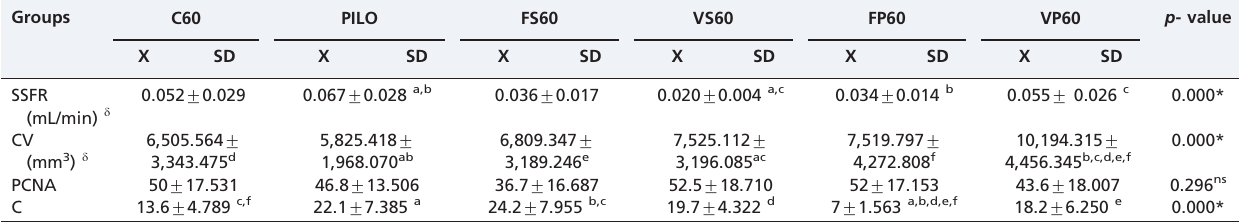
Table 3 - Mean values (X) and standard deviations (SD) of the studied variables in the groups treated for 60 days with saline (C60), pilocarpine (Pilo), fluoxetine and saline (FS60), venlafaxine and saline (VS60), fluoxetine and pilocarpine (FP60), or venlafaxine and pilocarpine (VP60).